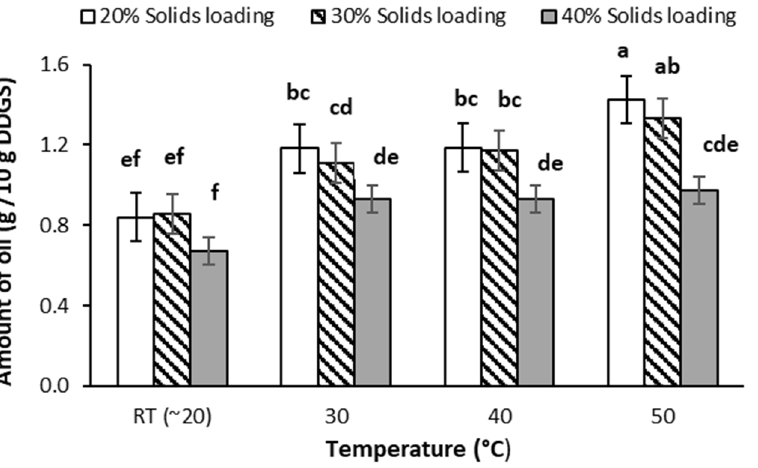
Figure 2. Effects of temperature and solids loadings on the amount of oil recovered from heavy fraction DDGS (# 20 sieved and aspirated). Letters a–e refer to the significant difference from each other.